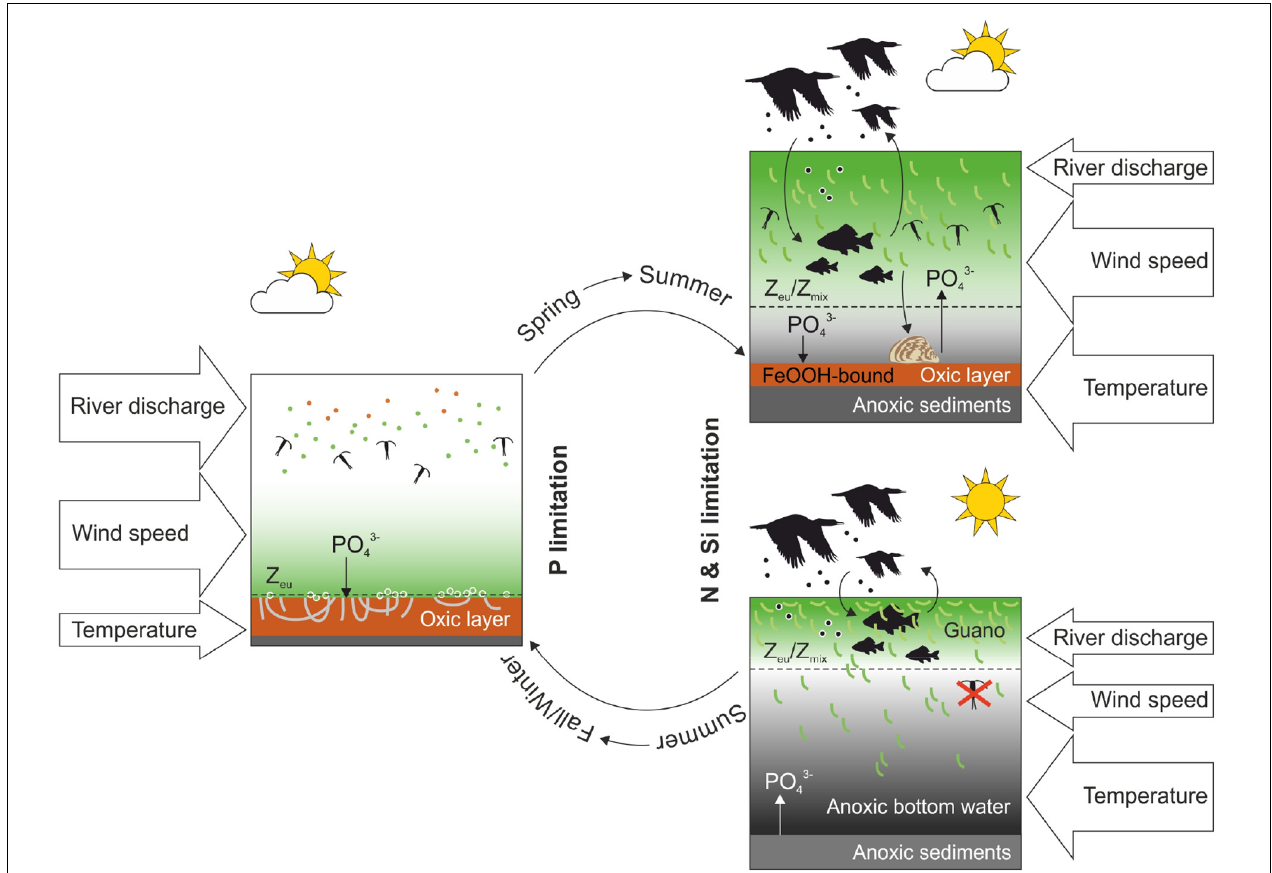
FIGURE 6 | Drivers of cyanobacterial blooms in the Curonian Lagoon during the transition from spring to summer. The lower panel on the right represents a hyperbloom event, leading to water anoxia.